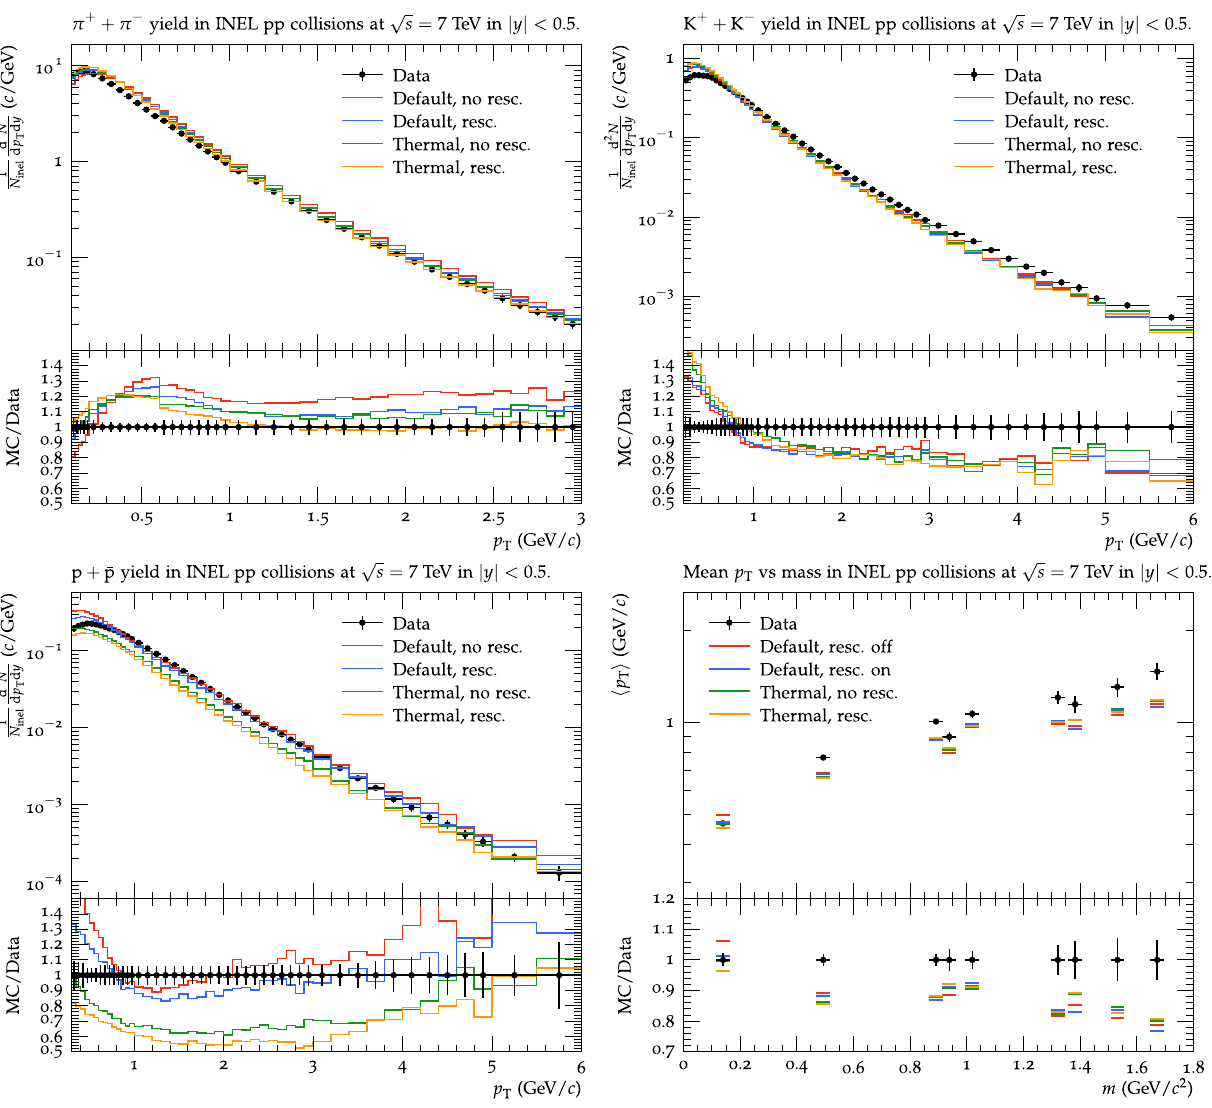
Fig. 21 p ⊥ spectra for π ± , K ± and p / p and average p ⊥ for various particles, with comparing the Gaussian to the thermal model. When using the thermal model, pT0Ref has been tuned to 2.47 without rescattering and 2.52 with rescattering on, in order to maintain the correct n